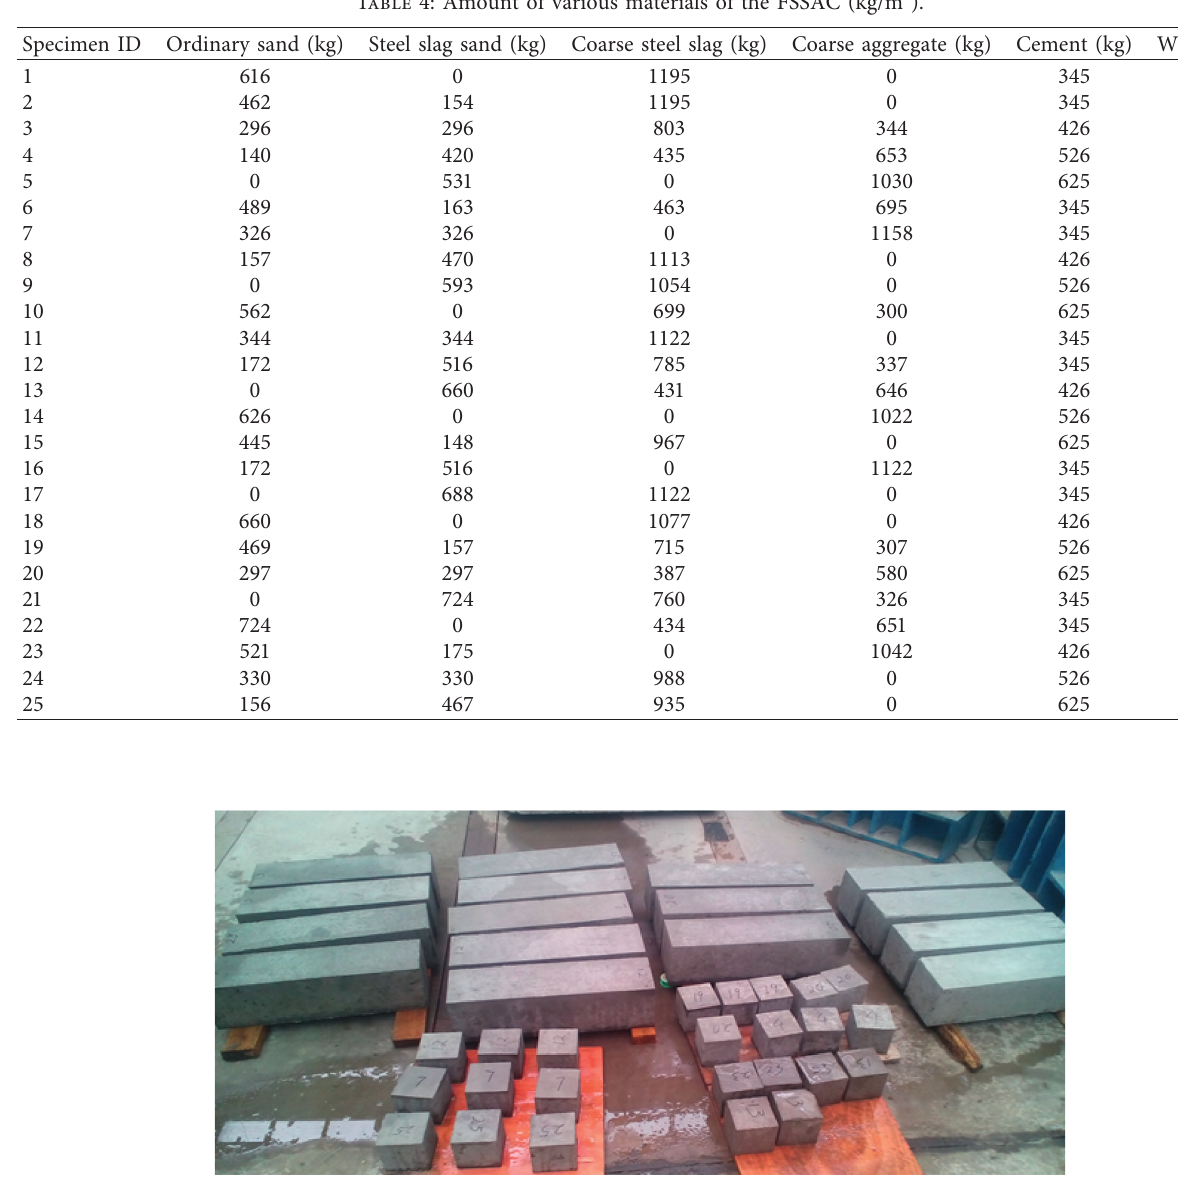
Figure 1: The FSSAC stub columns and cube test